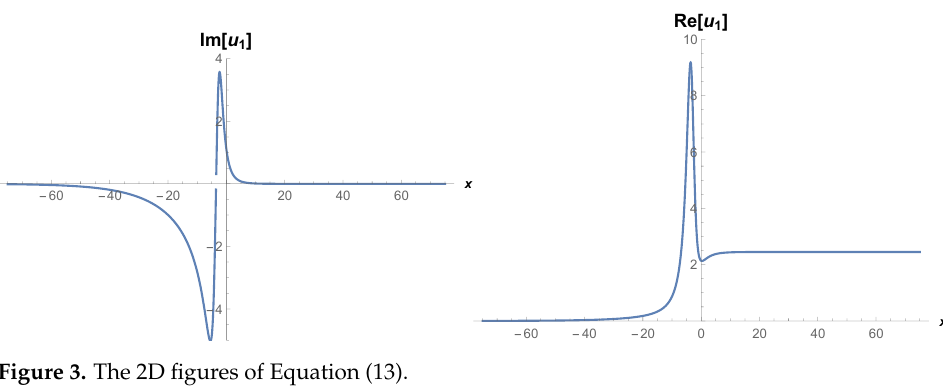
Figure 2. The contour figures of Equation (13).